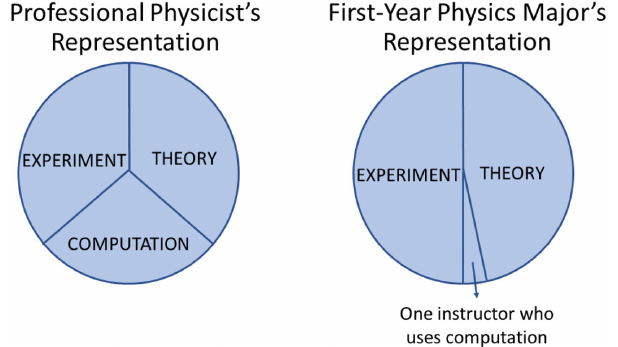
FIG. 3. Pie charts representing possible internal representations of the physics community ’ s practices that a professional physicist (left) and first-year physics major (right) might adopt based on their differences in experience. A professional is likely to give comparable space to computation, experiment, and theory, while a first-year major might have limited experience with computa- tion, leading to different expectations of the practices used by the physics